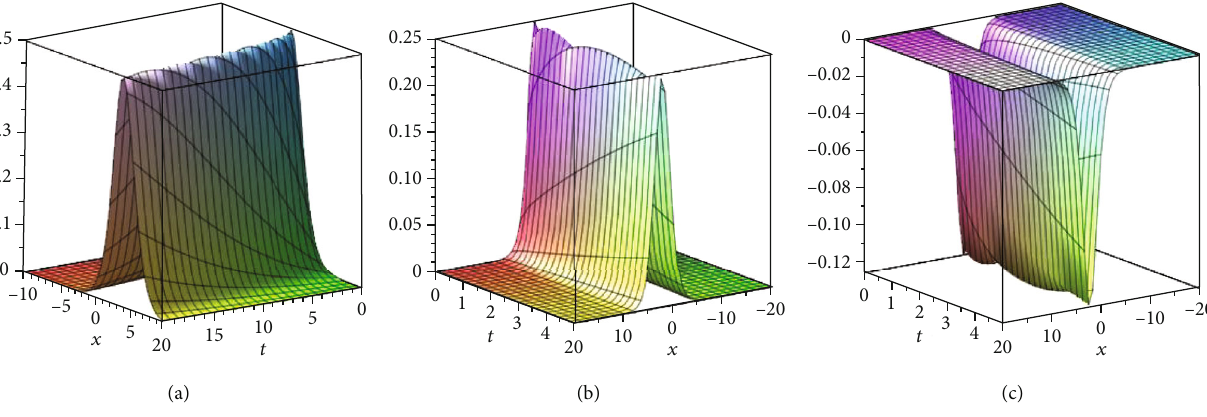
Figure 3: Plots of solution (20) for α = 0 : 5, b